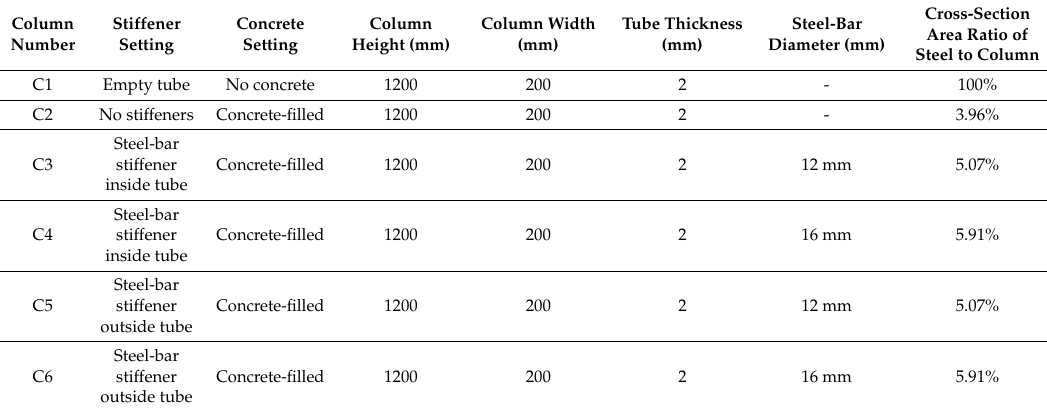
Table 1. Specimen